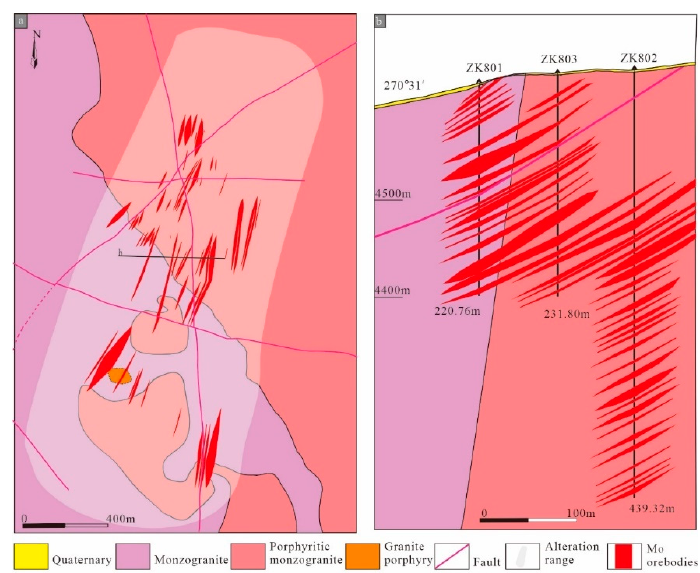
Figure 2. Geological map of the Reshui Mo deposit, East Kunlun. ( a ) Geological sketch map of the Reshui Mo deposit (after Guo et al. [23]); ( b ) cross section along No. 8 exploration lines through the Reshui porphyry Mo deposit (after [34]).